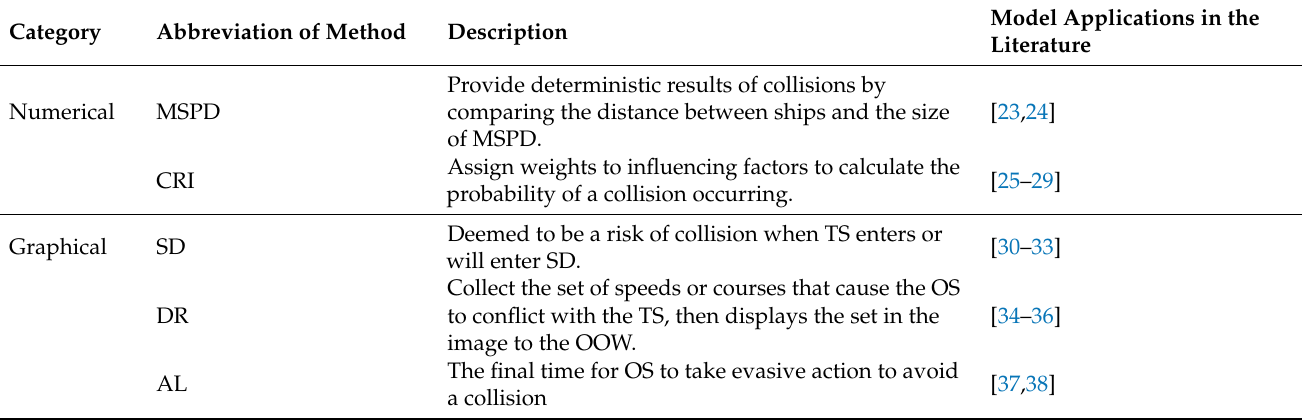
Table 4. Overview of ship risk perception methods and the application of corresponding